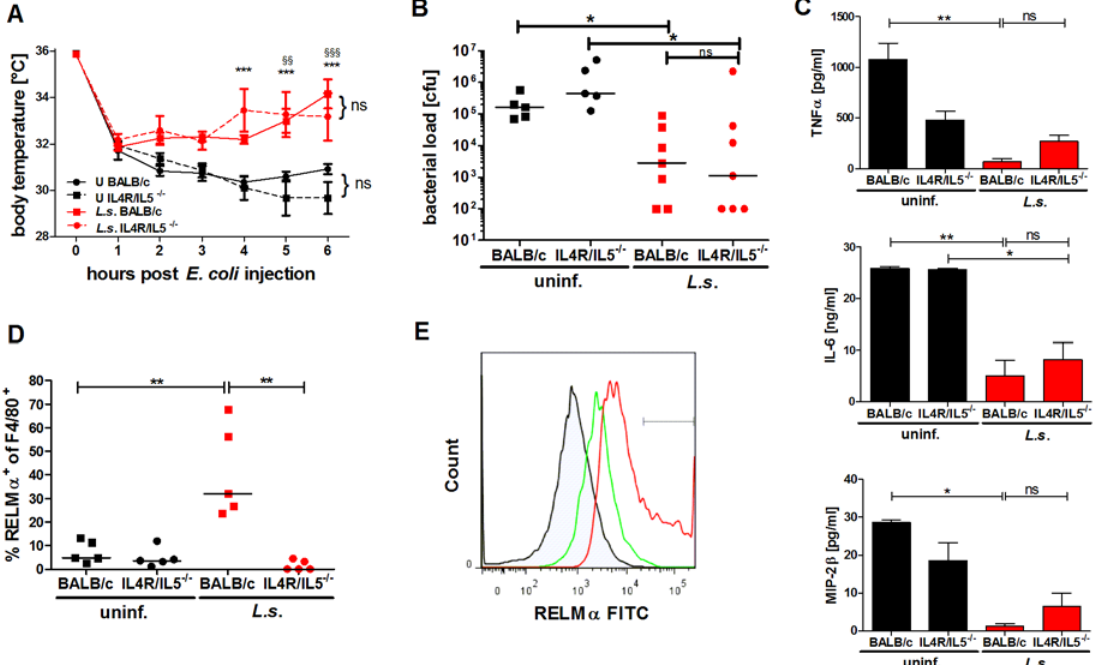
Figure 4. L. sigmodontis -mediated protection against E. coli -induced sepsis is not compromised in AAM-deficient IL-4R α -/- /IL-5 -/- mice. (A) Kinetic of body temperature in response to i.p. E. coli injection of uninfected (U) and chronic L. sigmodontis ( L.s. )-infected wild type and IL-4R α /IL-5-deficient mice. (B) Peritoneal bacterial load, (C) serum concentrations of TNF α , IL-6 and MIP-2 β and (D) frequency of F4/80-positive peritoneal macrophages that are RELM α positive in those animals six hours post E. coli injection. (E) Representative histogram of RELM α fluorescence intensity of F4/80-positive peritoneal macrophages (isotype control (shaded), L.s. -infected IL-4R α /IL-5-deficient mice (green), L.s. -infected wild type mice (red)). ( A-D ) Representative dataset from one of two independent experiments with at least 5 mice per group. Data shown in ( A ) is displayed as mean +/- SEM and was tested for statistical significance by 2-way ANOVA and Bonferroni post-hoc test (asterisks indicate significant differences between L.s. -infected and uninfected IL-4R/IL-5ko mice and paragraphs between L.s. -infected and uninfected wild type mice). ( B, C ) and ( D ) data was tested for statistical significance by 1-way ANOVA followed by Dunn ’ s post-hoc test. * p < 0.05, ** p <